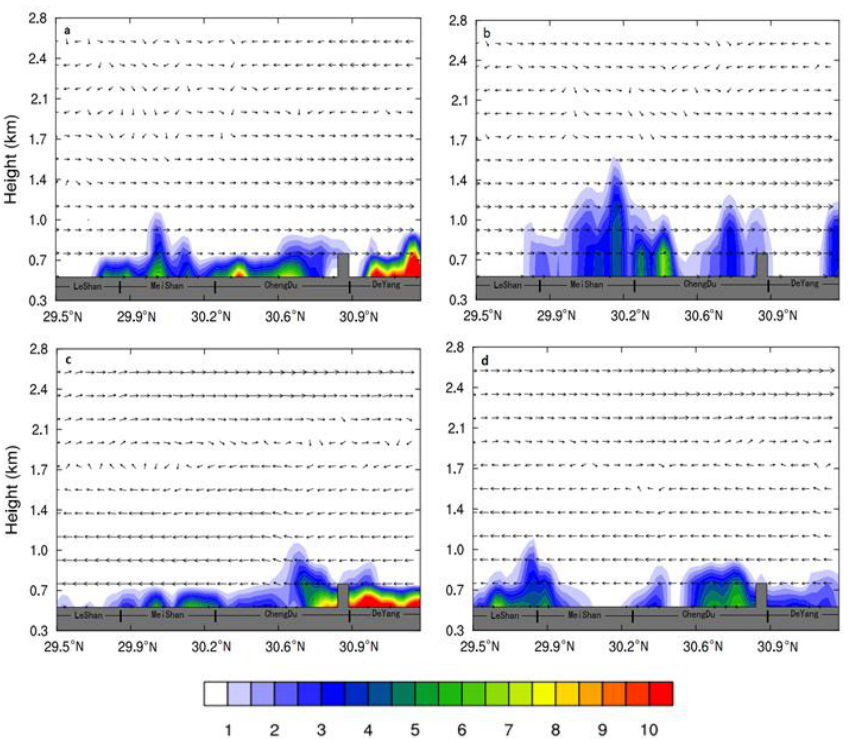
Figure 14. Vertical profile of the volume fraction of pollutants (10 − 4 ) and wind (m · s − 1 ) (along line CD in Figure 6b): ( a ) 0000 UTC on 7 May; ( b ) 0400 UTC on 7 May; ( c ) 0000 UTC on 8 May; and ( d ) 0400 UTC on 8 May. Note: the gray shaded area signifies the topography.